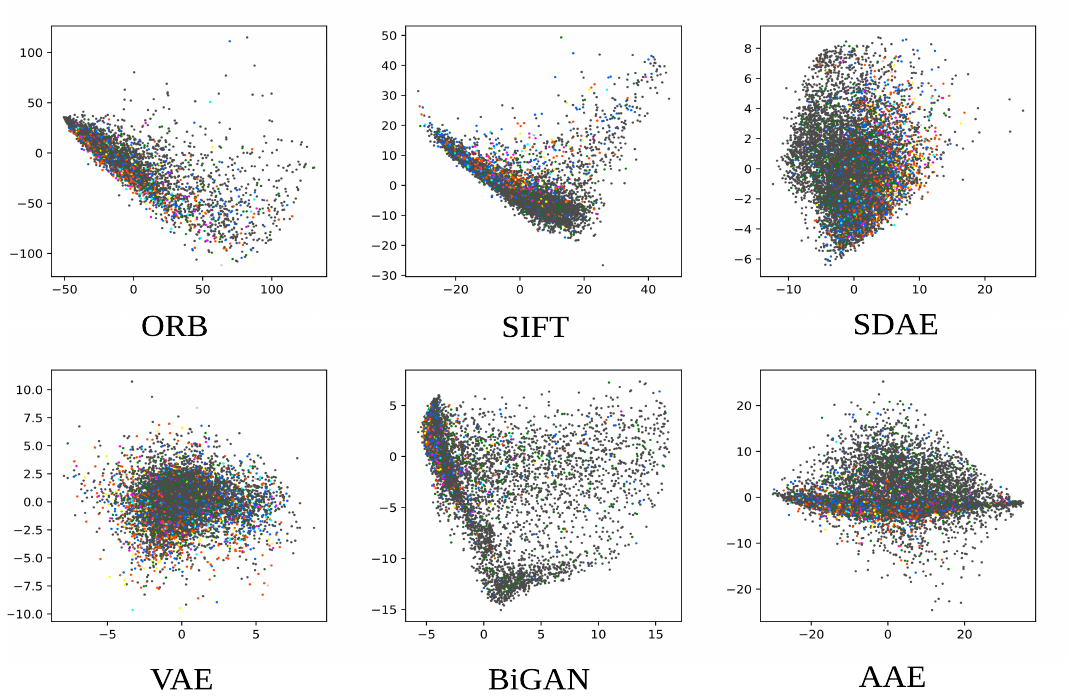
Figure 6. The 2D projections of the latent codes in the validation set, for each learned feature space. Best seen in